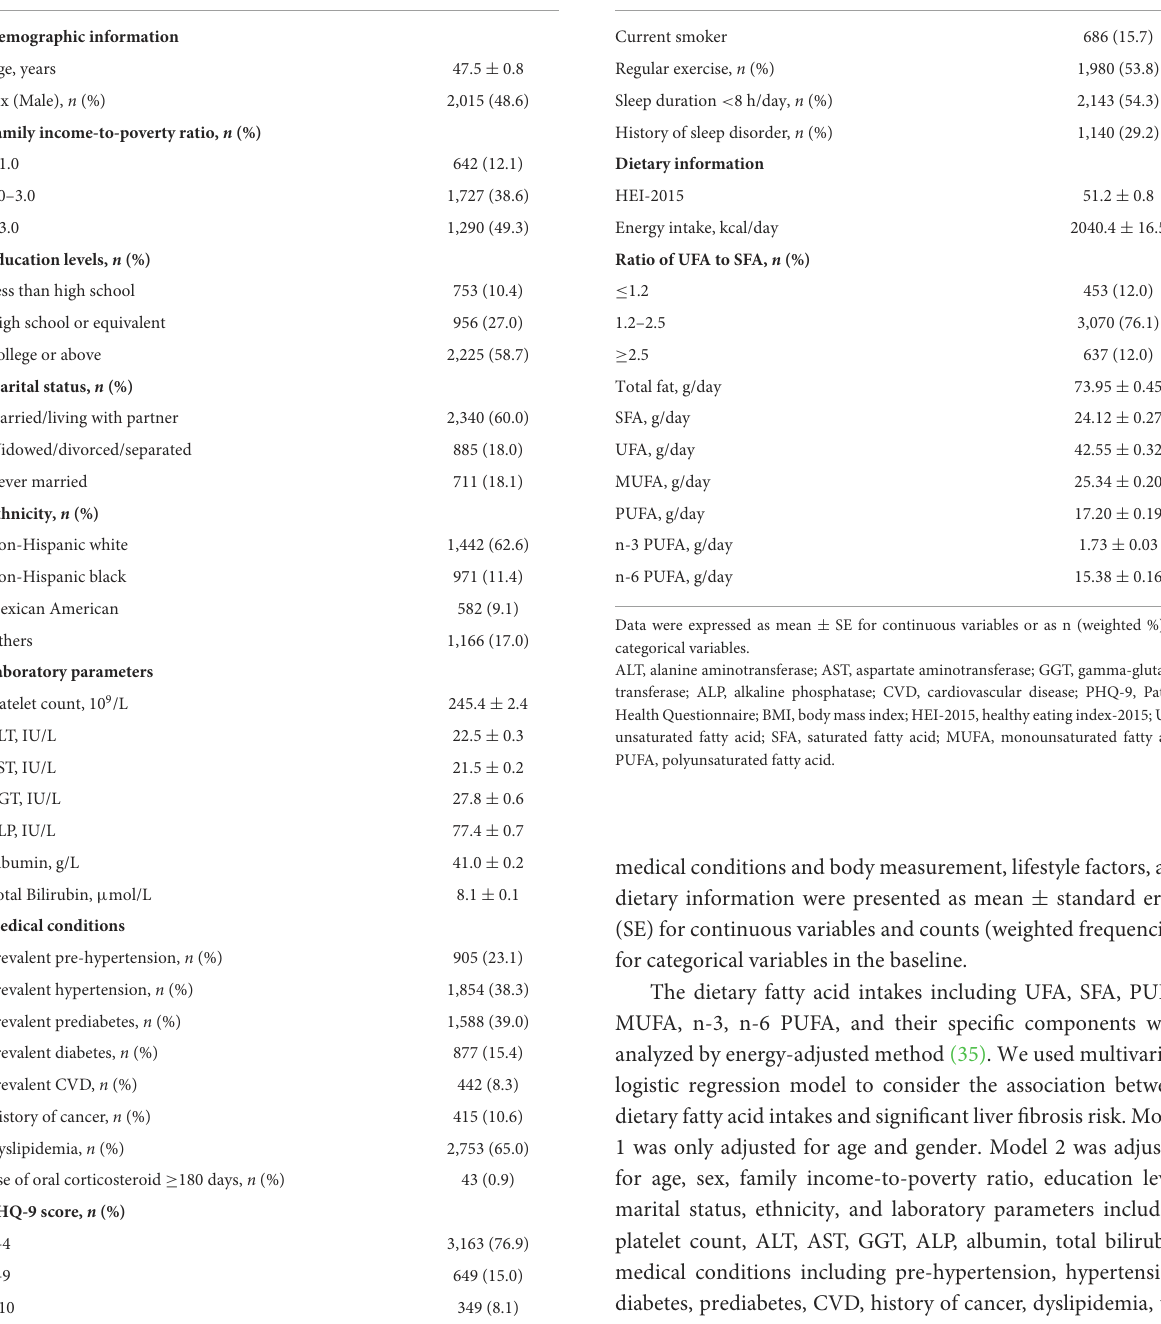
TABLE 1 Baseline characteristics of the participants.